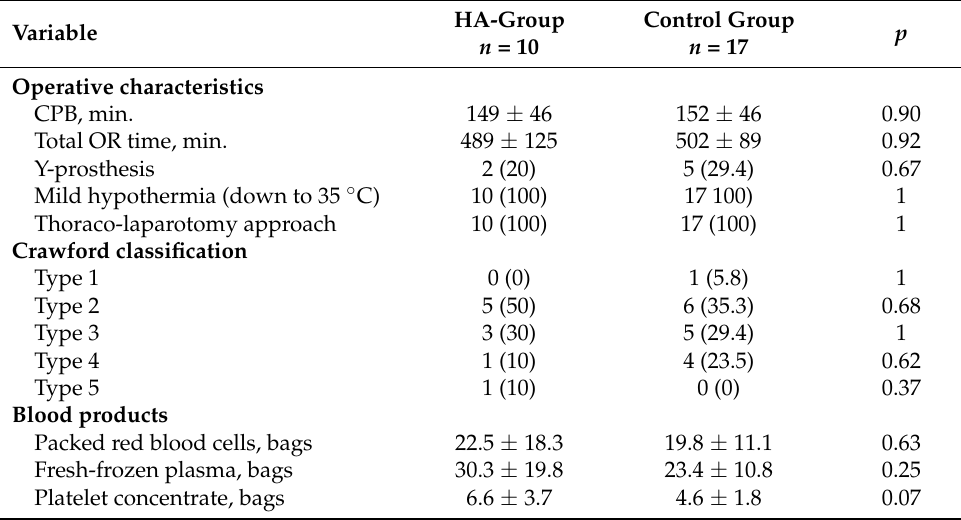
Table 2. Operative and postoperative